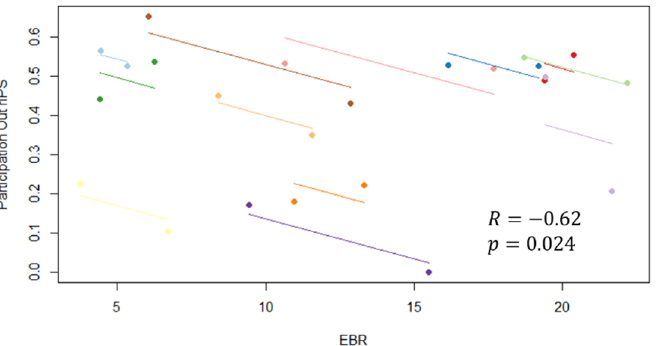
Figure 11. Results of repeated measures correlation between blink parameter Eye Blink Rate (EBR) and participation out of rIPS in the alpha band.